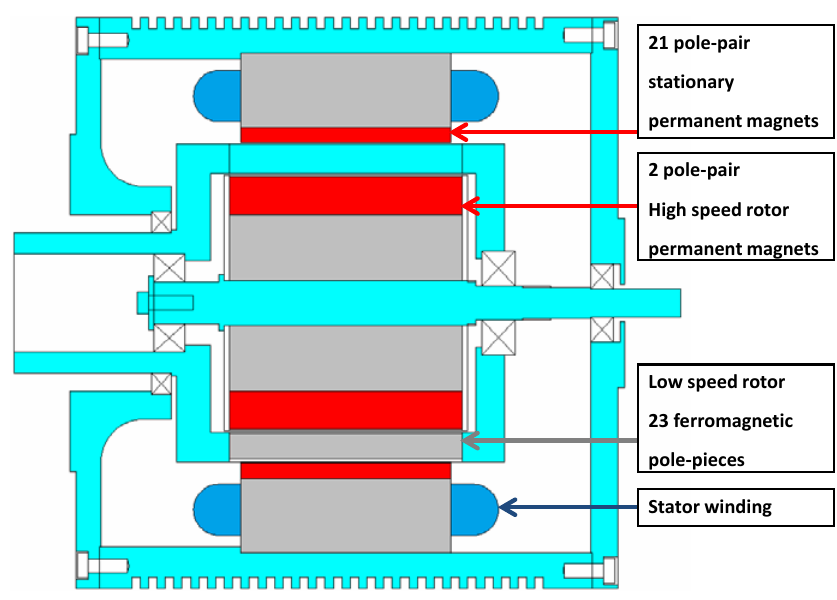
Figure 2. Axial cross-section of the